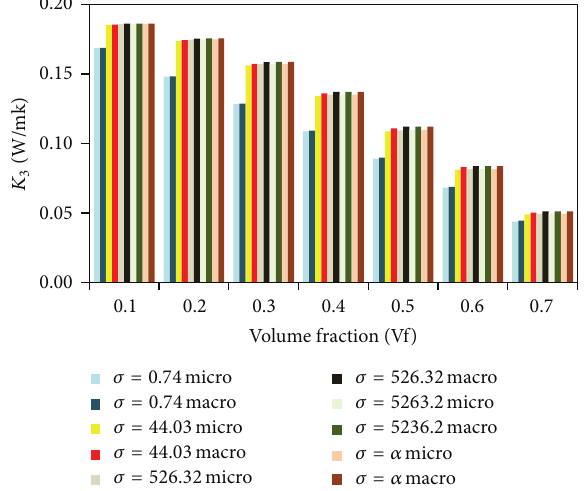
Figure 15: Variation in 𝐾 3 with respect to Vf of a composite with alternate layers of fibres fully debonded.